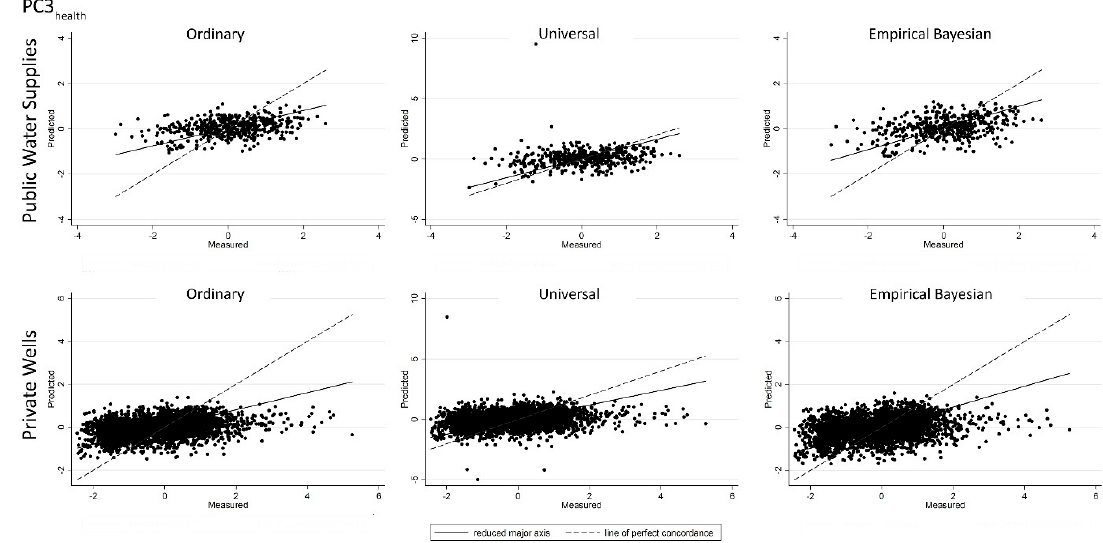
Figure A4. Predicted vs. measured values for PC3 health scores obtained from the cross-validation results for ordinary, universal, and empirical Bayesian kriging for: public water supplies ( top row ); and private wells ( bottom row ). Line of perfect concordance indicated by dashed line.